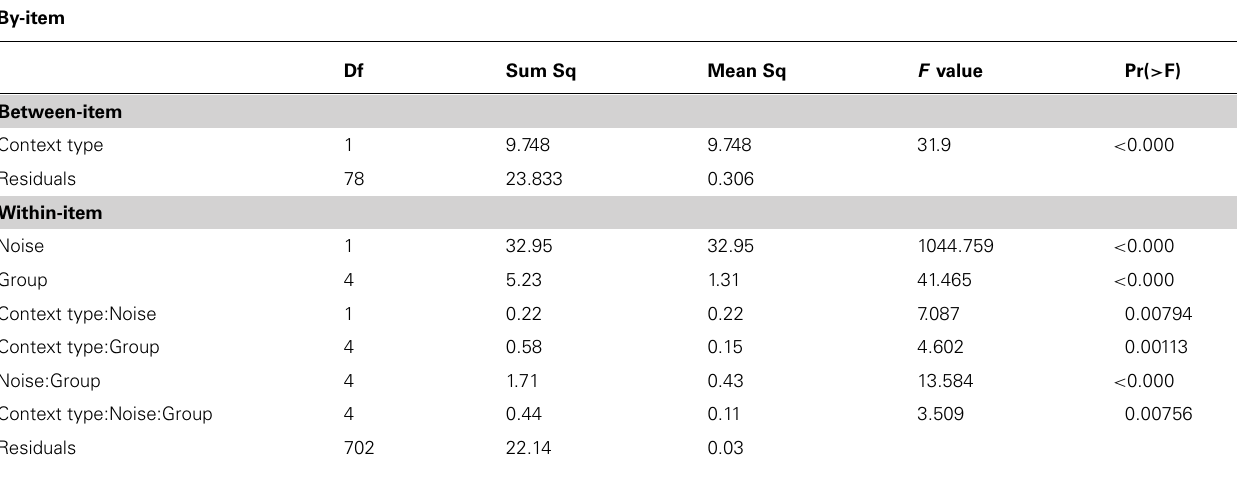
Table 4 | Repeated measuresANOVA results for Experiment 1: speech in noise, by-item analyses.